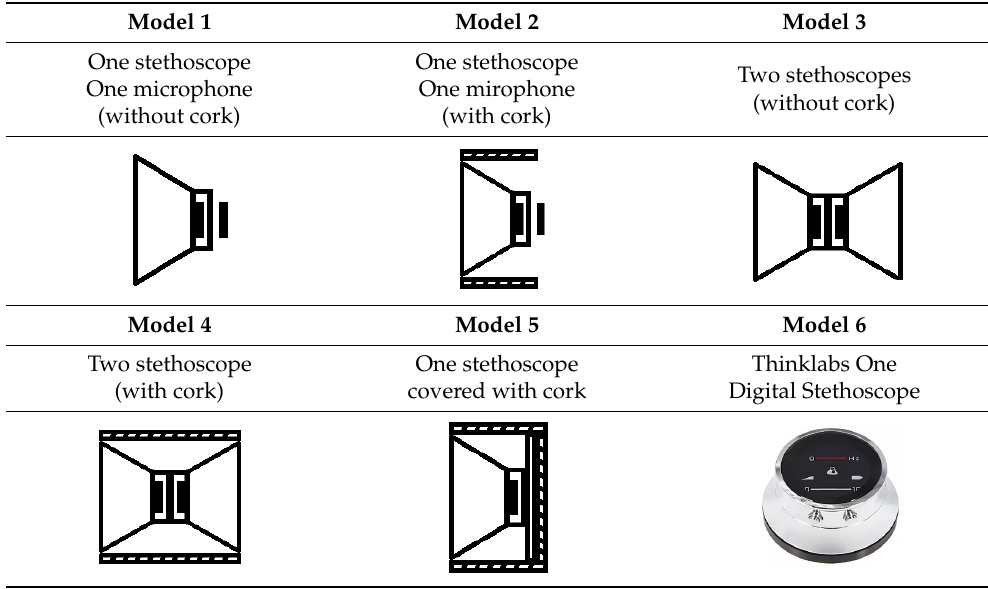
Table 1. Six different models of electronic stethoscope heads.